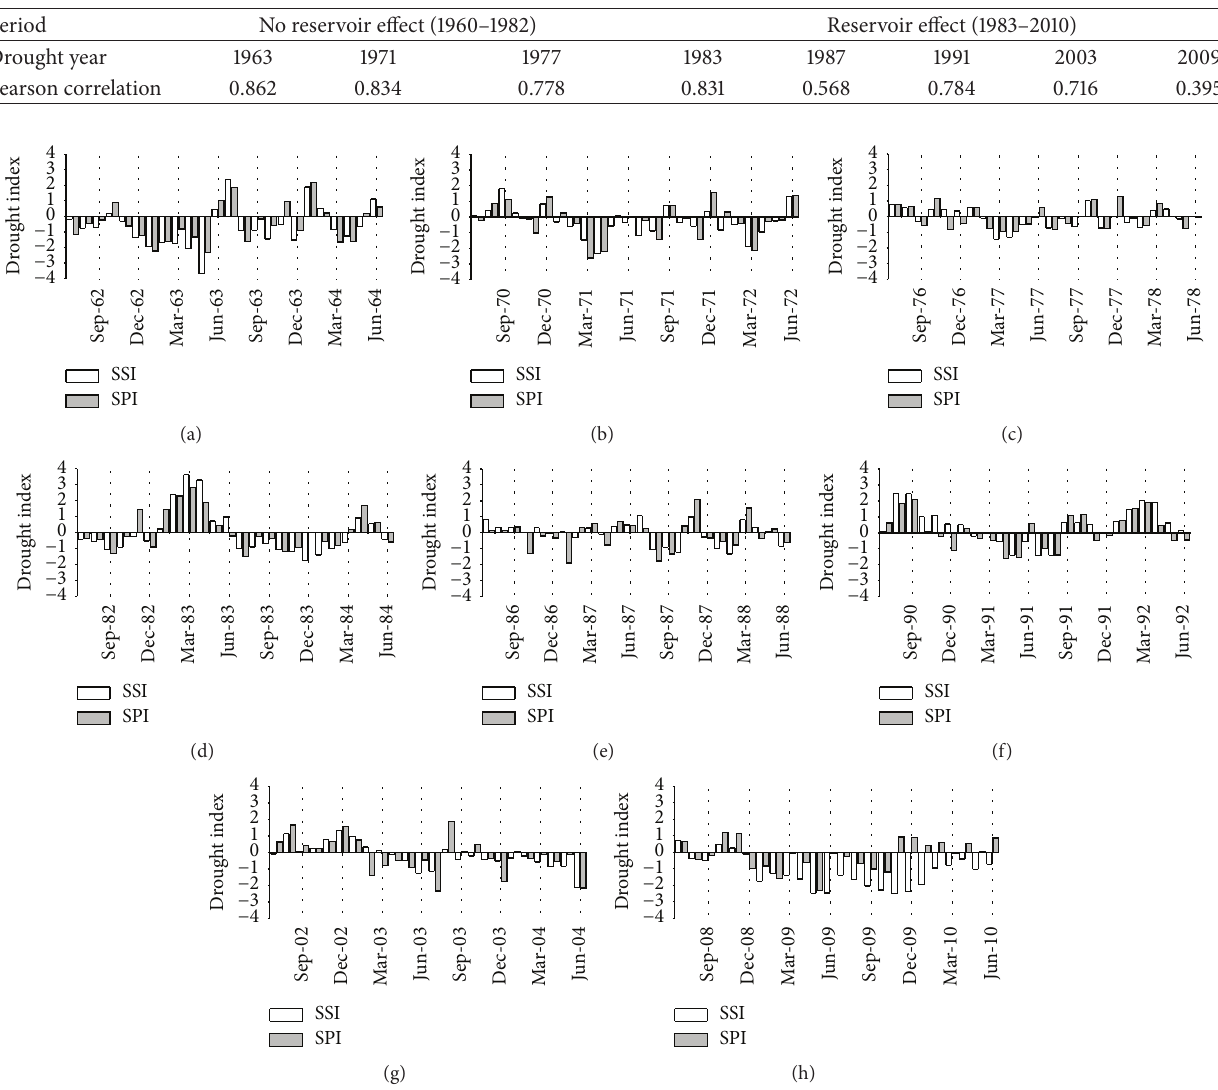
Table 4: Correlations between SSI and SPI in typical severe drought years.